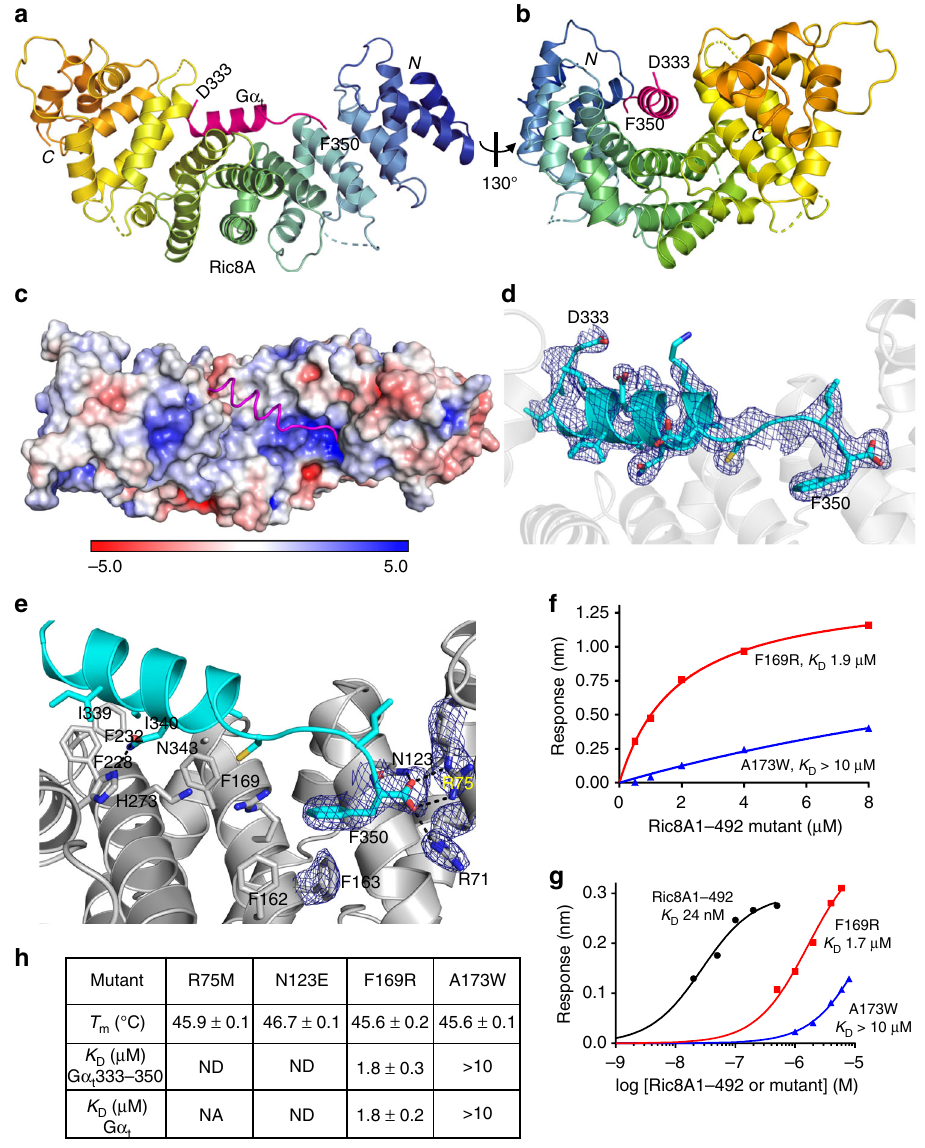
Fig. 3 Interface of Ric8A with the C-terminus of G α t1 . a View of G α t 333 – 350 (magenta) bound to the concave surface of Ric8A (rainbow), based on the structure of the Ric8A1 – 492/MBP-G α t 327 – 350 complex. b View highlighting curvature of the concave binding surface of Ric8A. c Electrostatic surface representation of Ric8A with the bound G α t 333 – 350 (magenta tube), showing helical residues G α t 335 – 346 interacting with the neutral surface and the C-terminal-most residues contacting the positively charged patch (units K b T / e c ). d An omit map ( F o- F c) for G α t 333 – 350 is contoured at 2.5 σ and shown for 1.6 Å around the ligand. e Close-up of the interface between Ric8A (gray) and the G α t C-terminus (cyan). Omit maps ( F o- F c) for G α t F350 and its critical Ric8A contact residues R71, R75, N123, and F163 are contoured at 2.5 σ and shown for 1.6 Å around the side chains. f , g Properties of the mutations that alter Ric8A/G α t 333 – 350 interface. Representative steady-state binding curves from BLI assays measuring the binding of Ric8A1 – 492 mutants F169R and A173F to biotinylated G α t 333 – 350 ( f ) or Ric8A1 – 492 and its F169R and A173F mutants to Avi-tagged G α t ( g ) coupled to a streptavidin biosensor. h Table showing thermostability (DSF assay) and G α t 333 – 350 and the full-length G α t steady-state binding af fi nities of Ric8A1 – 492 mutants calculated from the BLI assays (mean ± SD, n = 3). ND – not detectable. NA – not available. Source data are provided as a Source Data fi le. Stereo images of 3d and 3e are available in Supplementary Fig.